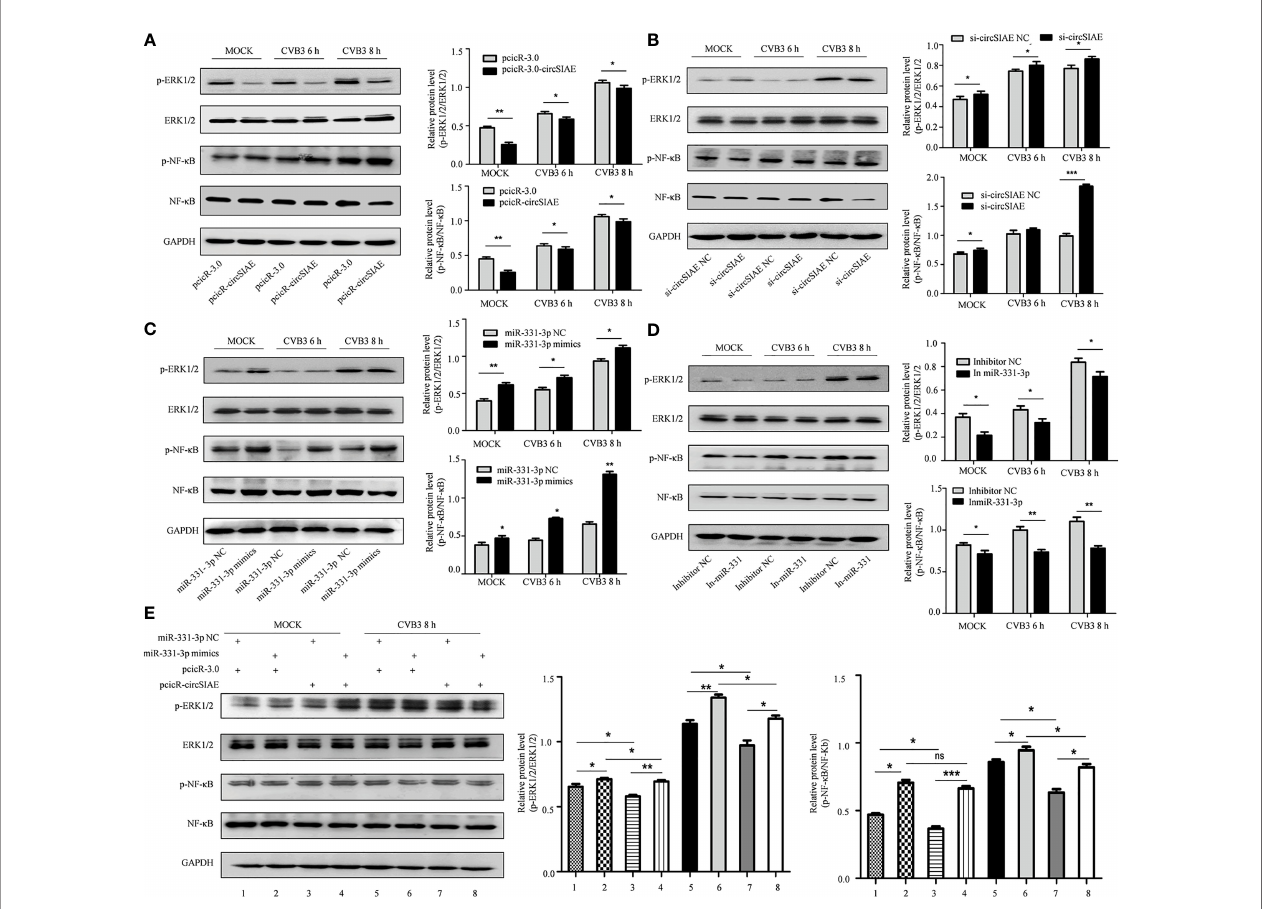
FIGURE 7 | The effect of the circSIAE/miR331-3p/TAOK2 axis on the ERK/NF- k B in fl ammation pathway. (A – D) After transfection with pcicR-circSIAE/si-circSIAE/ miR-331-3p mimics/miR-331-3p inhibitor and its control for 36 h, total protein of cells infected with CVB3 for 6 h and 8 h were extracted. The levels of p-ERK1/2, ERK1/2, p-NF - k B and NF- k B were detected by Western blot. The histograms on the right showed the levels of protein as quanti fi ed by densitometric analysis using ImageJ. (E) Total protein of cells transfected with pcicR-3.0-circSIAE and miR-331-3p were extracted following 8 h of infection with CVB3. The relationship between ERK1/2 and NF- k B protein was veri fi ed by Western blot. *p < 0.05, **p < 0.01, ***p < 0.001, ns, no statistically signi fi